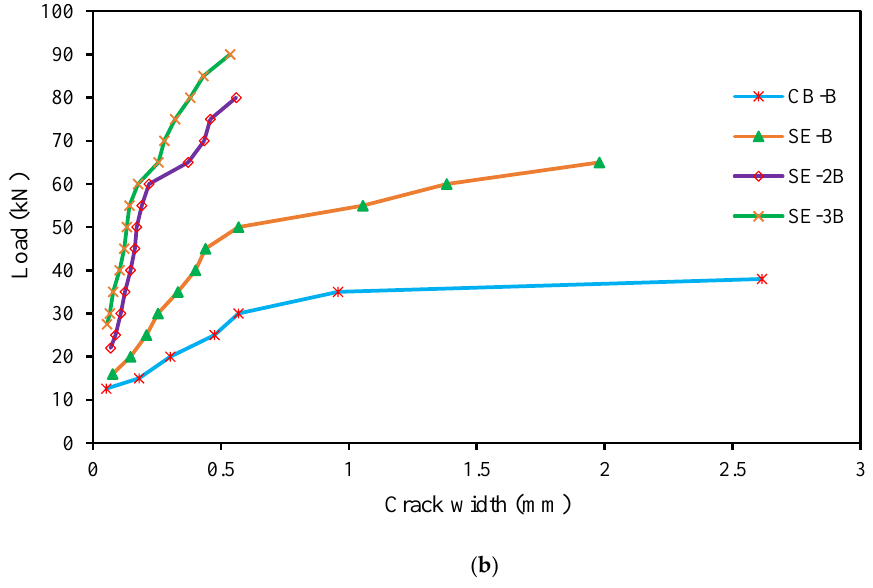
Figure 9. Crack width at several load level. ( a ) series-A; ( b ) series-B. Table 3. Tested results for